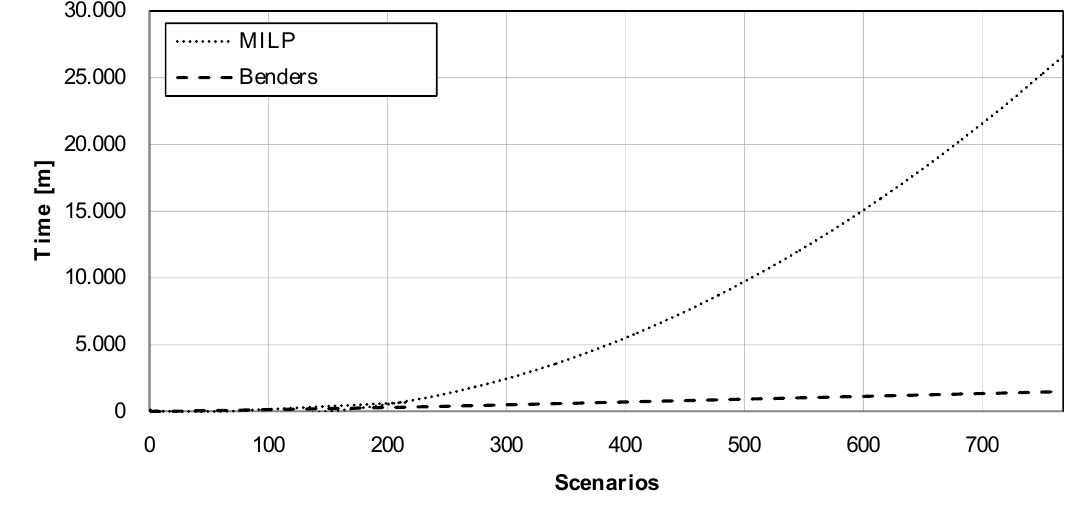
Figure 4. CPU time for Case b.